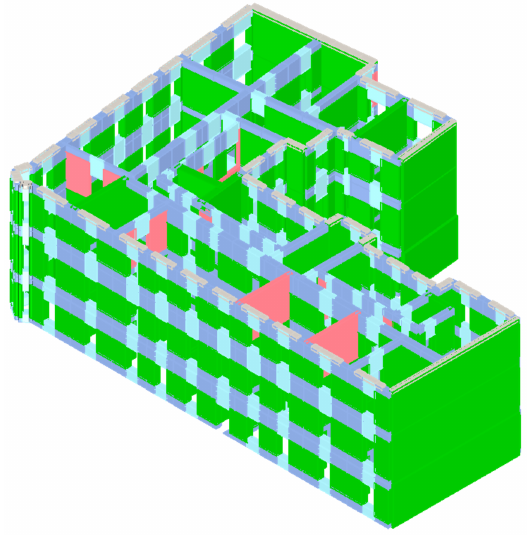
Figure 21. The bending out-of-plane